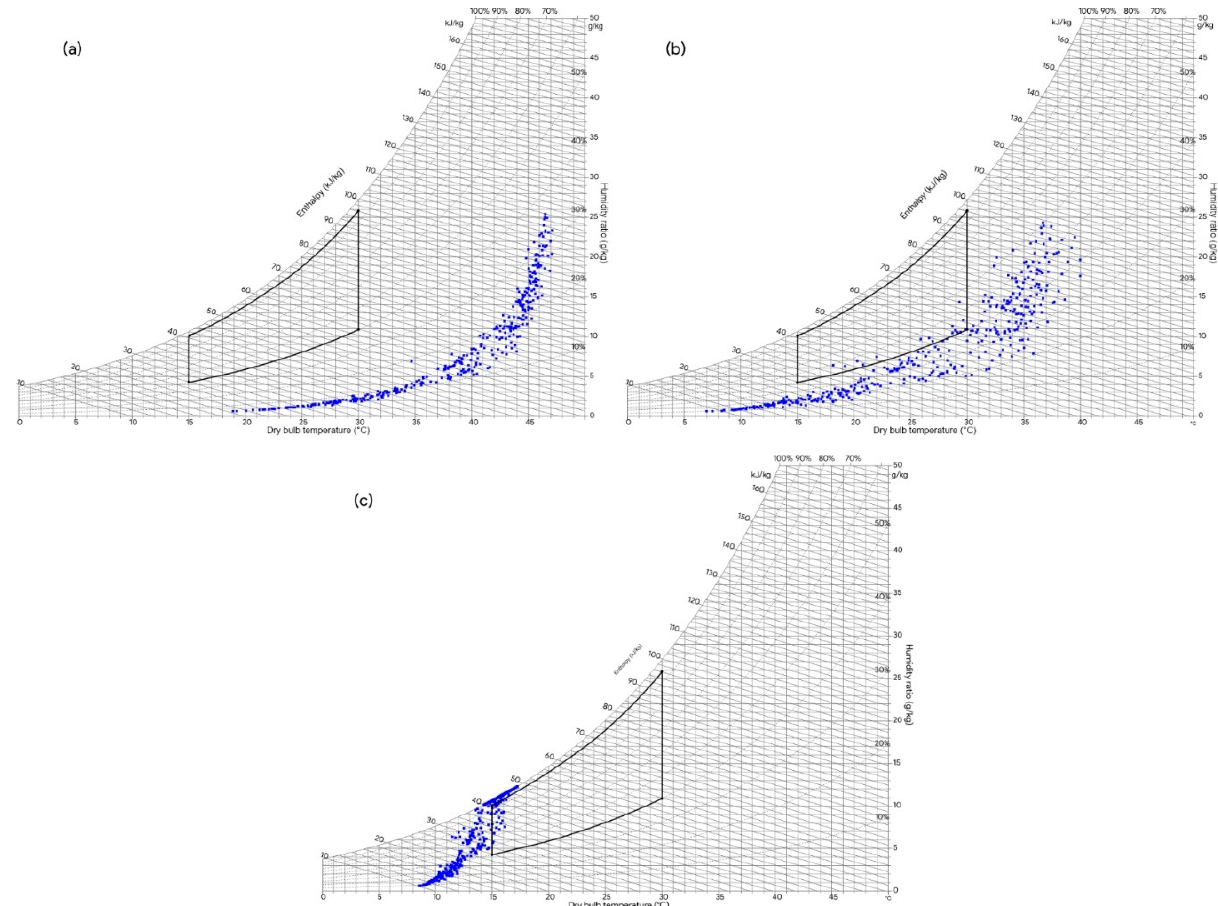
Figure 9. Profile of annual temperature and relative humidity of ( a ) standalone desiccant air-conditioning (DAC) system, ( b ) desiccant air-conditioning coupled with sensible heat exchanger (DAC+HX) system, and ( c ) desiccant dehumidification Maisotsenko cycle evaporative cooling (M-DAC) system, for greenhouse air-conditioning.